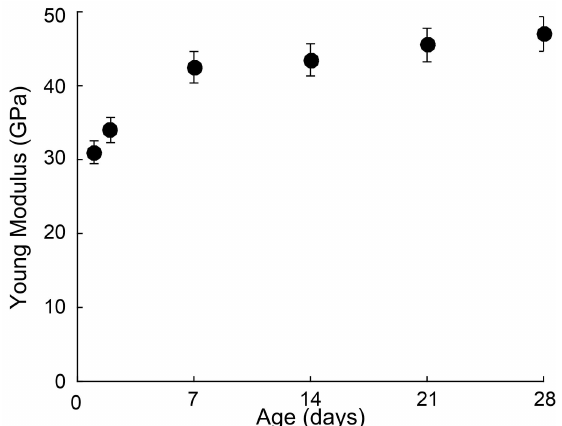
Figure 13. Elastic modulus of concrete specimens stored at 20 ◦